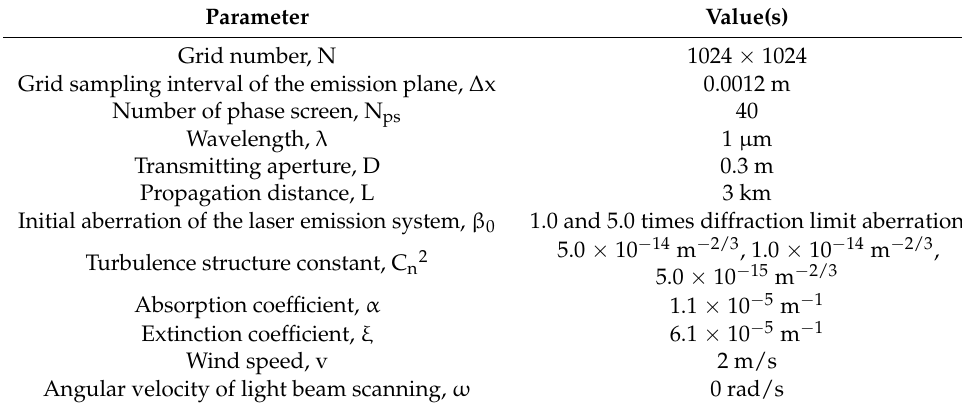
Table 1. Parameters of interest in the 4D wave optics simulation.